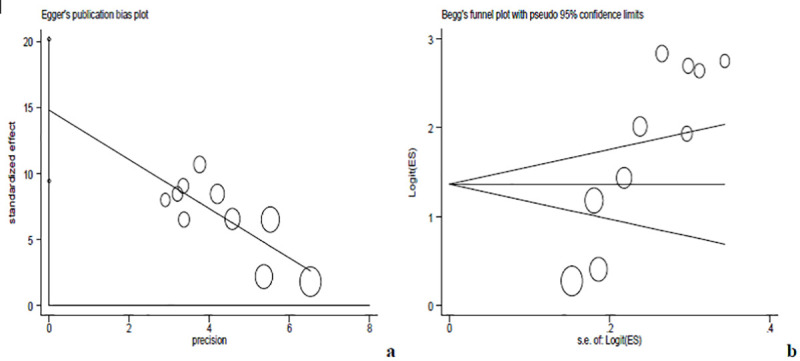
Eggers’s publication bias plot (a) and Begg’s funnel plot (b) reports for HIV infected individual studies.